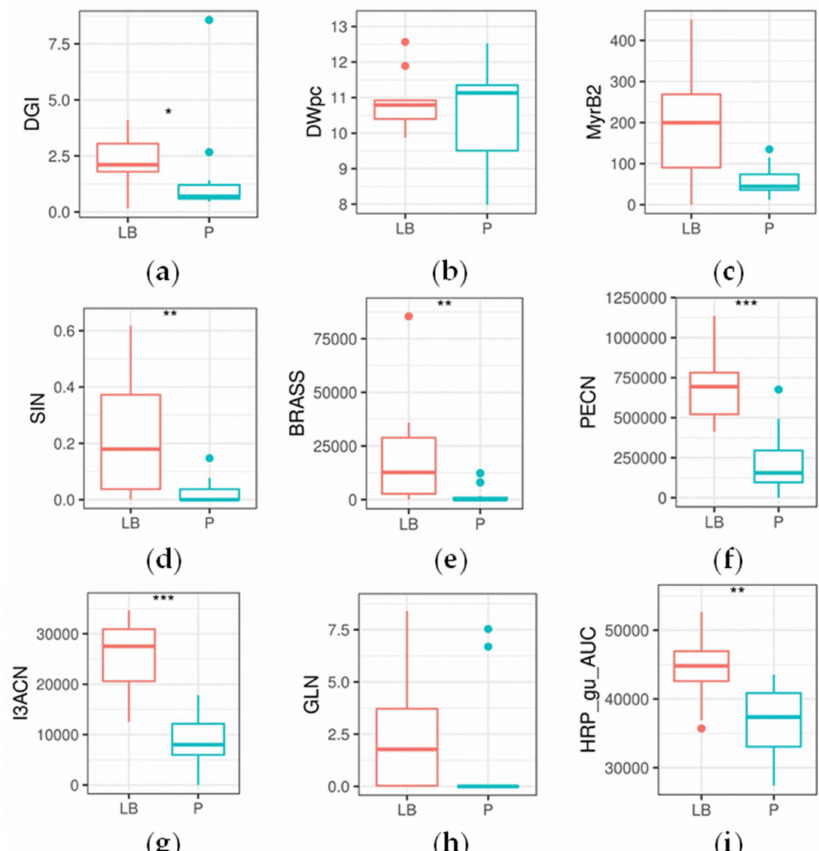
Figure4. Boxplotsshowingstatisticaldi ff erencesinglucosinolateandbreakdownproductconcentration, enzymatic activity and general parameters between the horseradish hairy root culture lines of petiole (P) and leaf blade (LB) origin ( n = 11 and n = 10, respectively). Significant changes are marked as follows: * p < 0.05; ** p < 0.01; *** p < 0.001; Kruskal–Wallis test. Subplots ( a ) daily growth index; ( b ) dry weight (%); ( c ) Myrosinase, activity of the second band as measured by on-gel analysis; ( d ) sinigrin content ( µ g mg − 1 ); ( e ) glucobrassicin content (abundance); ( f ) 3-phenylpropionitrile content (abundance); ( g ) indole-3-acetonitrile content (abundance); ( h ) gluconasturtiin content ( µ g mg − 1 ); ( i ) horseradish peroxidase content activity, as measured on-gel analysis with guaiacol as